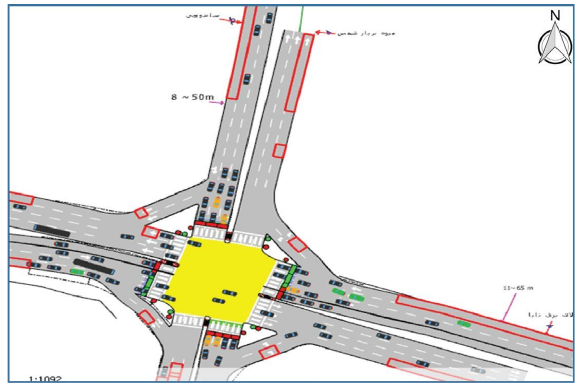
Figure 5: Encoding trafc violations in Aimsun simulation